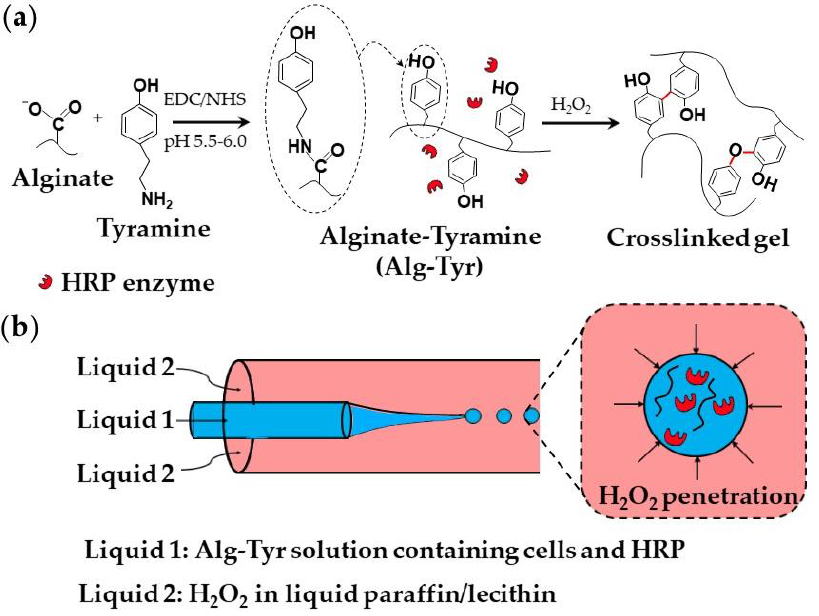
Figure 18. ( a ) Modification of alginate with tyramine via carbodiimide chemistry and the synthesis of alginate-tyramine gel by HRP-catalysed crosslinking of alginate-tyramine conjugate with H 2 O 2 . C-C and C-O bonds formed between phenol moieties of tyramine are shown in red. ( b ) Generation of aqueous droplets containing alginate-tyramine, cells, and HRP in a co-flowing stream of liquid paraffin saturated with hydrogen peroxide (H 2 O 2 ) [70].